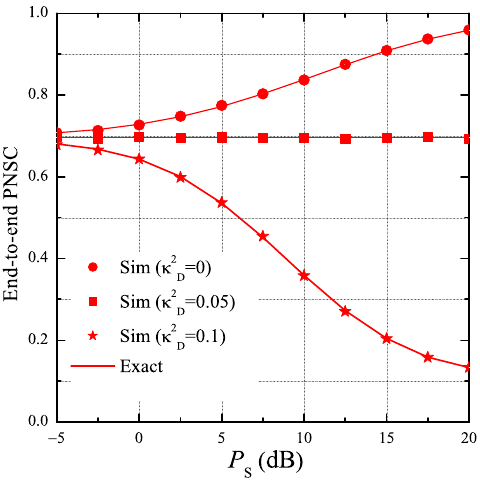
Figure 9. End-to-end probability of non-zero secrecy capacity as a function of P S when K = 3, ε = 0.25, η = 0.25, x B = 0.5, y B = 0.3, x P = 0.5, y P = − 0.5, x E = 0.5, y E = 0.5, κ 2